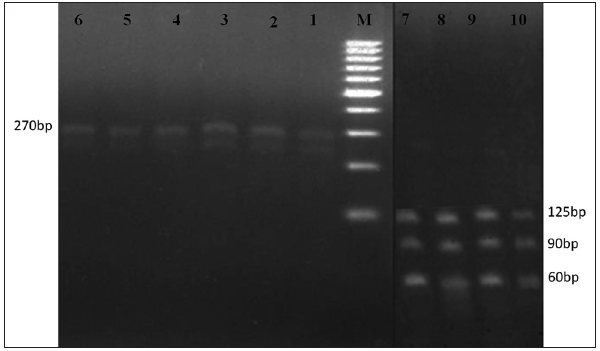
Figure-4: Restriction fragment length polymorphism digestion for AluI enzyme. Lane M: 100 bp marker, lanes 1-6: Identified restriction digestion products of AluI (270 bp) for northern samples, and lanes 7-10: Identified restriction digestion products (60, 90, and 125 bp) for southern samples.